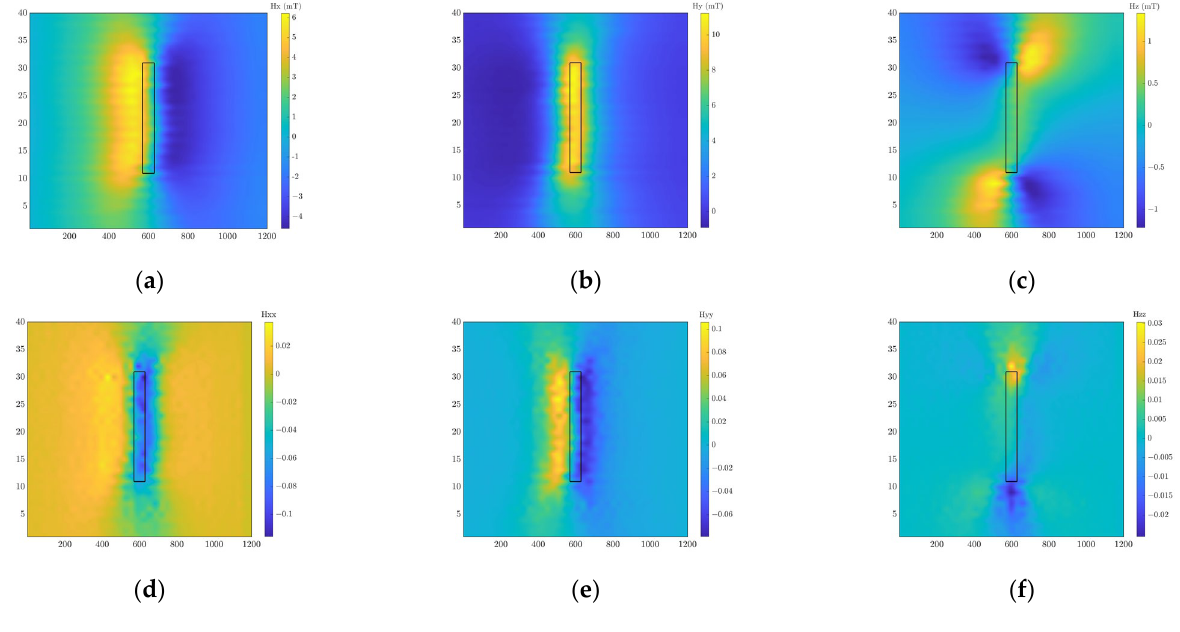
Figure 12. Two-dimensional distribution of defect characteristics. ( a ) Normal component signals. ( b ) Tangential component signals. ( c ) Horizontal component signals. ( d ) Gradient value of normal component signals. ( e ) Gradient value of tangential component signals. ( f ) Gradient value of horizontal component signals.